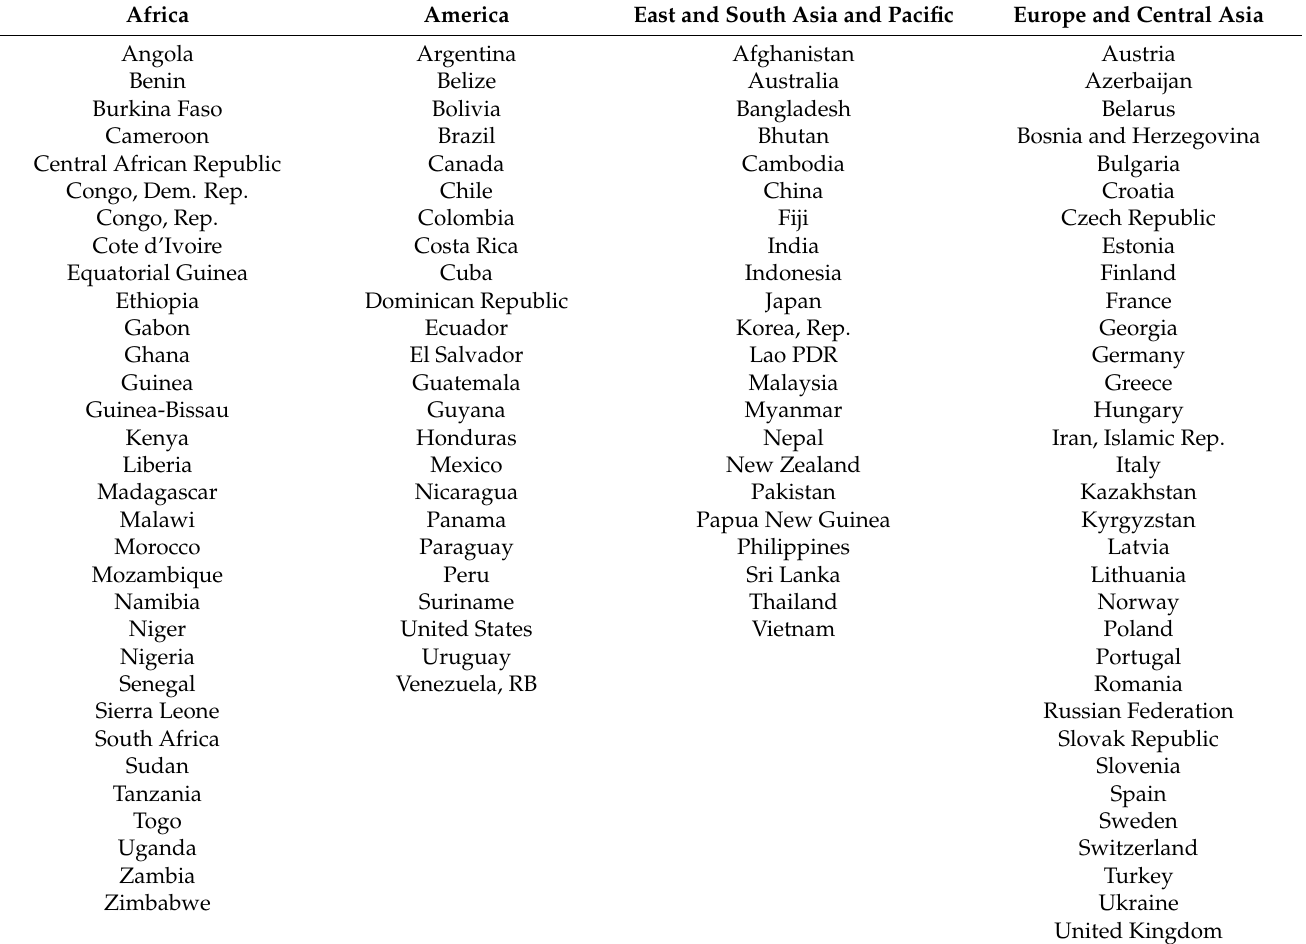
Table A1 on Appendix A and, a reduced form of the table is presented below (Table 3). Table 2. Countries included in the analysis.